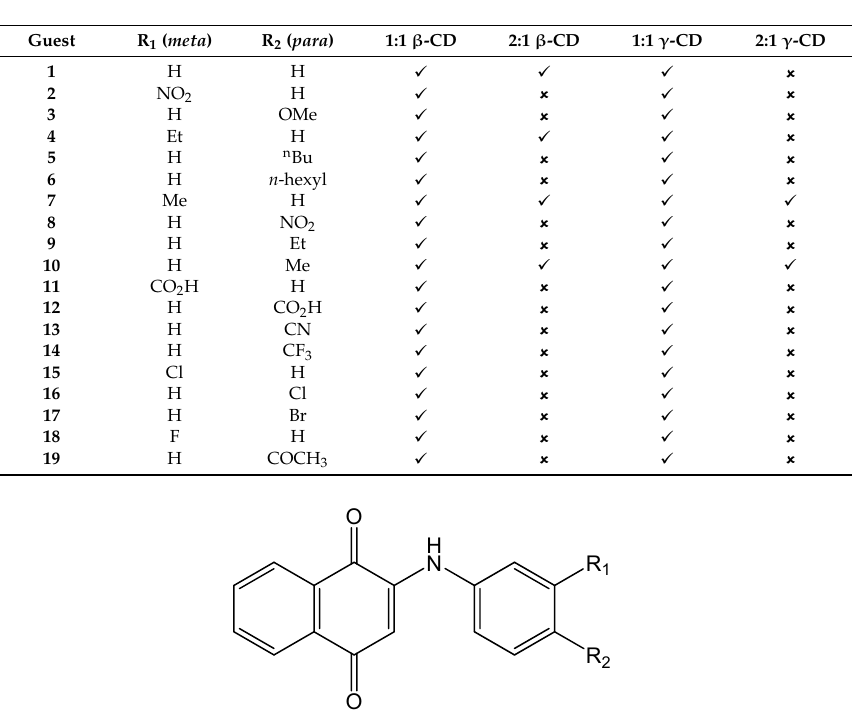
Figure 1. General structure of the 2-[(R-phenyl)amine]-1,4-naphthalenedione guests of interest. The list of the 19 specific guests studied and their R 1 and R 2 substituents is given in Table 1.